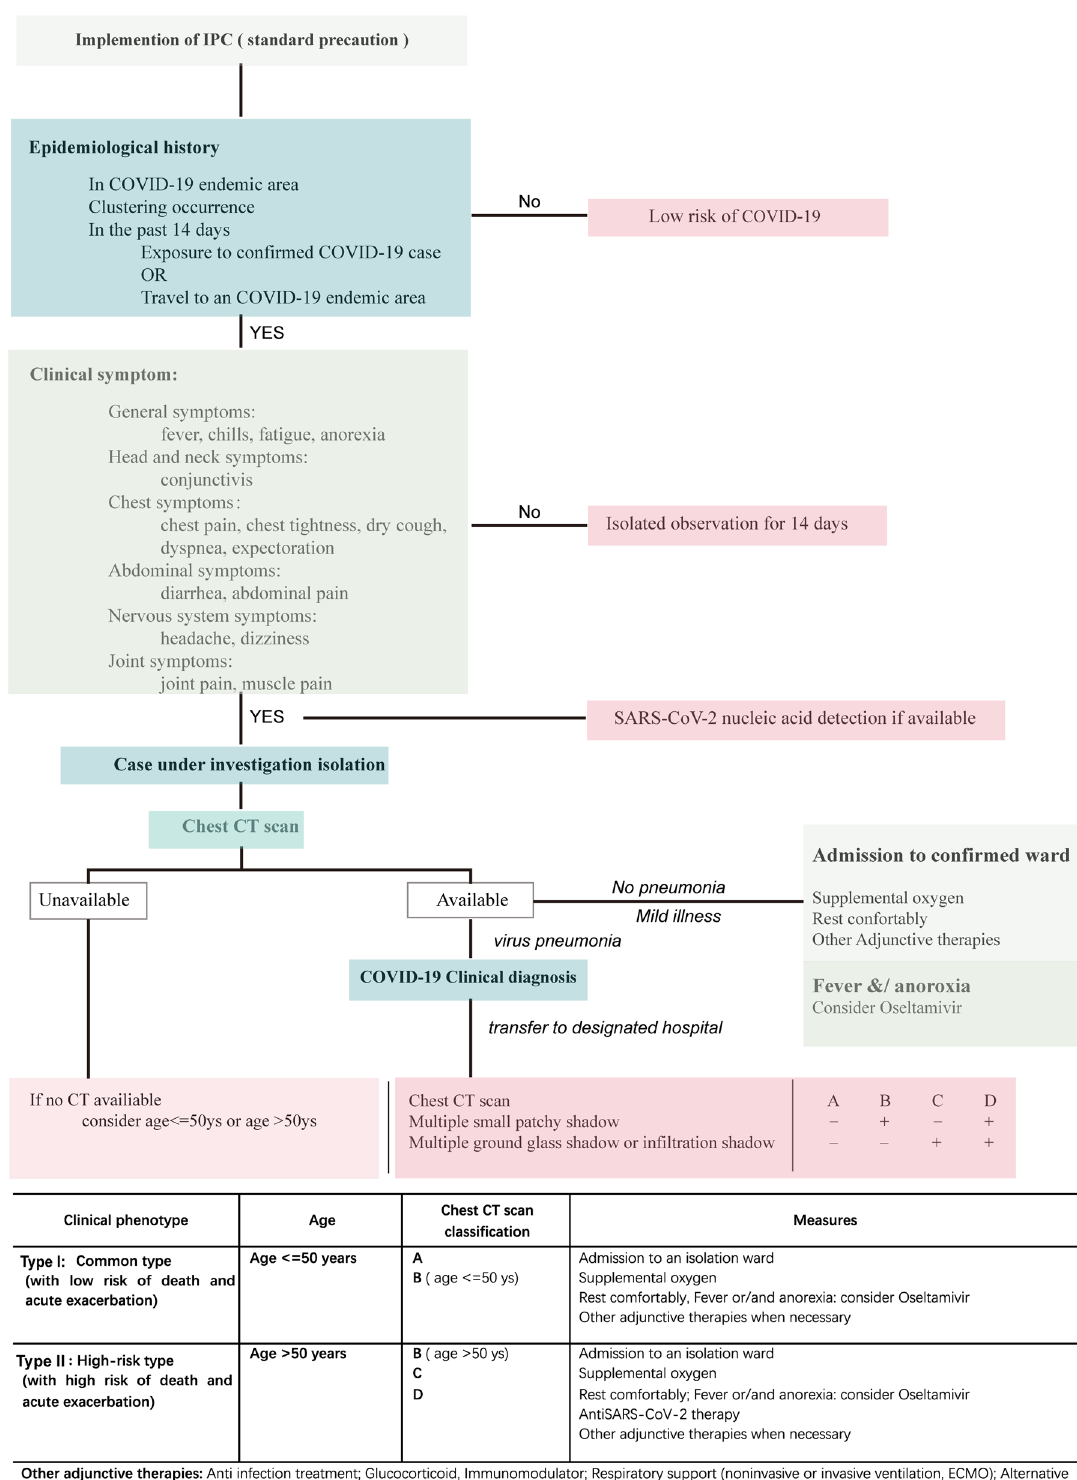
Figure 3. Proposed flow chart for treatment of general COVID-19